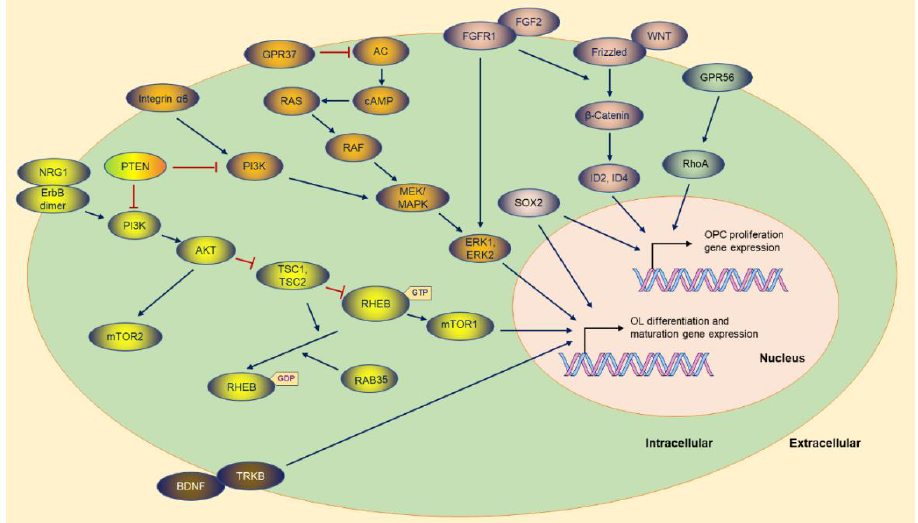
Figure 3. The molecules and the potential signaling pathway regulate the OPC proliferation and OL differentiation gene expression. Most of the molecules are exhibited, and the majority of the upstream molecules originate from the cytoplasmic membrane. The sign of blue arrows represents promoting, and the sign of red lines represents inhibiting. AC: Adenylate cyclase. FGF signaling is initially identified as an OPC proliferative signal retarding differen- tiation. However, in Fgfr1/Fgfr2 double knockout mice, OPC proliferation and OL differ- entiation are not affected, and the onset of myelination is on time [30]. Rapid myelin